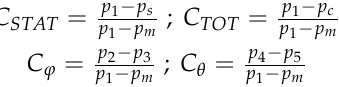
The calibration pressure coefficients with the probe rotation angles together create data for 3D graphs. Mathematical interpretation of these 3D surfaces (see Figure 4) in the form of a regression equation root matrix is one of the main inputs in the evaluation pro- cess from the wake traversing behind the nozzle and bucket [11].